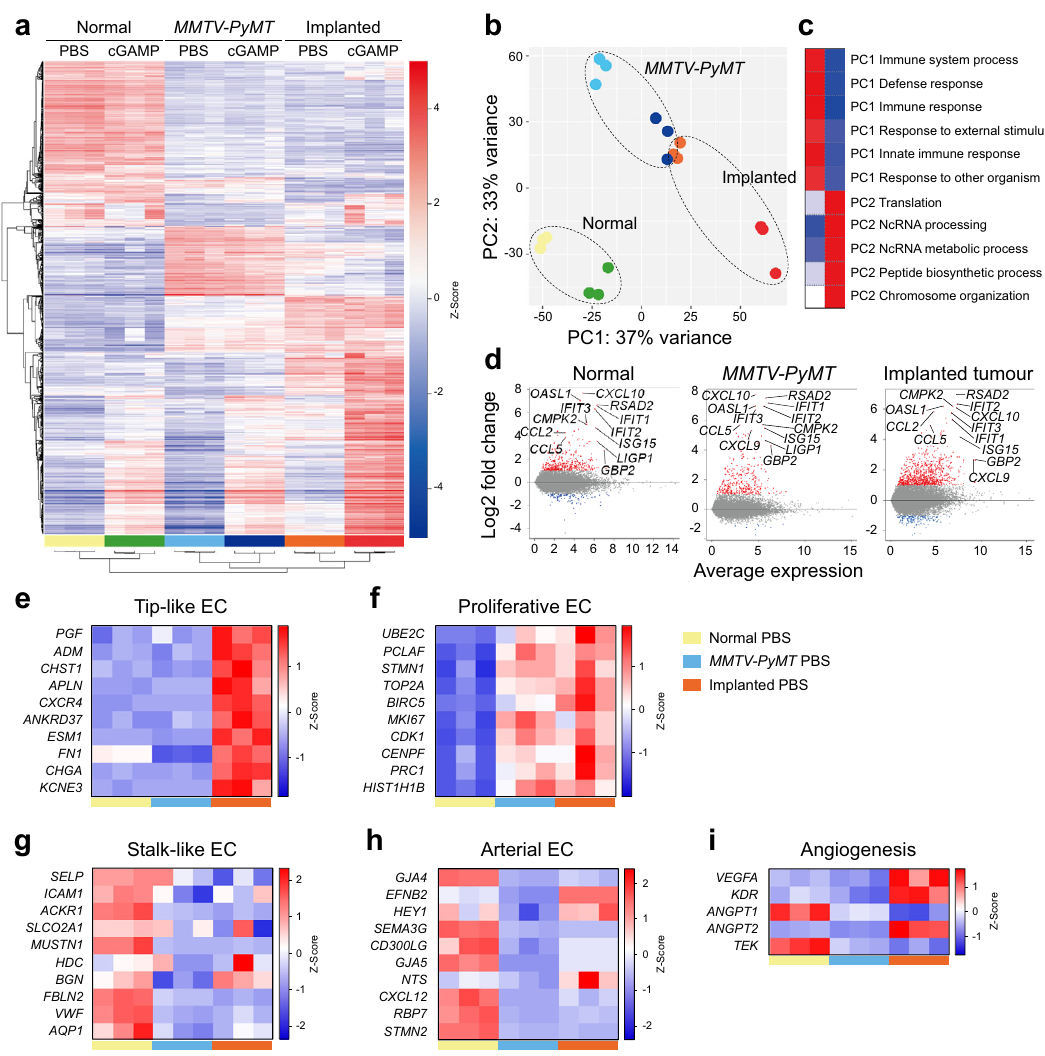
Fig. 7 Implanted breast tumour ECs exhibit angiogenic and in fl ammatory transcriptome pro fi les. a Heatmap of the RNA-seq data of ECs from normal mammary pads, MMTV-PyMT spontaneous breast tumours, and implanted breast tumours (see Fig. 6). n = 3 mice/group from three independent experiments. b Principal component analysis (PCA) of the RNA-seq data. c Gene ontology analysis of PCA axis. d MA plots showing differentially expressed genes by cGAMP treatment in each group. e – i Heatmaps comparing genes related to tip-like ECs, proliferative ECs, stalk-like ECs, arterial ECs, and angiogenesis in the ECs of normal mammary pads and spontaneous and implanted tumours treated with